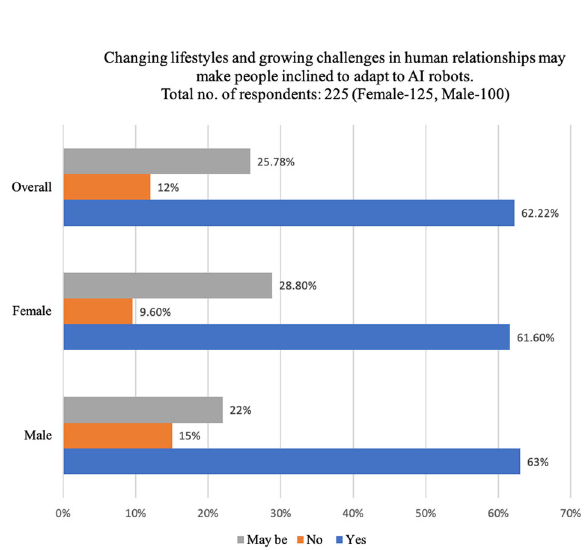
Fig. 1 Changing lifestyles and growing challenges in human relationships may make people inclined to adapt to AI robots. Total no. of respondents: 225 (Female: 125, Male: